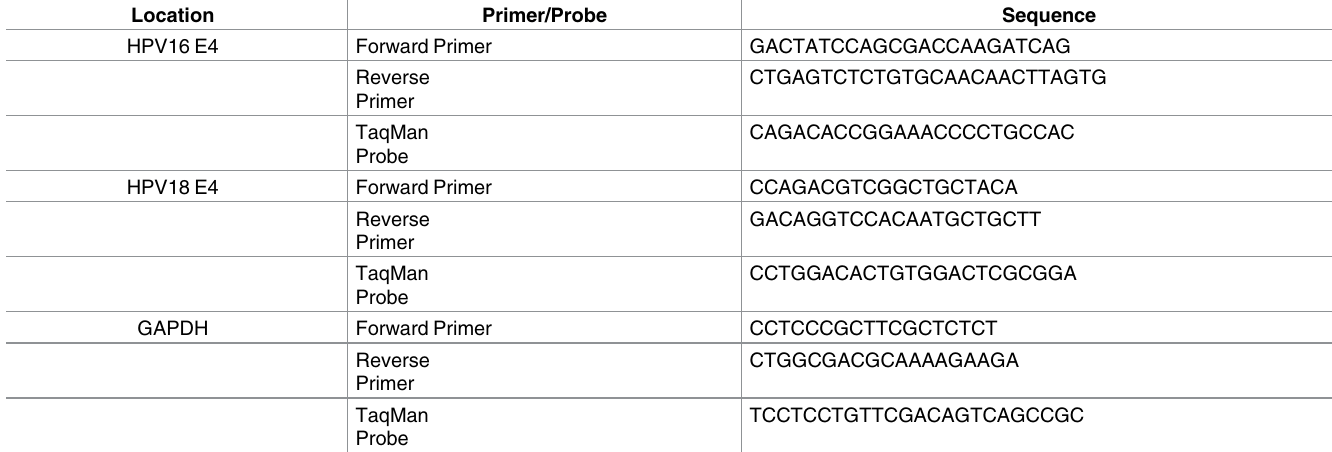
Table 1. Primer and